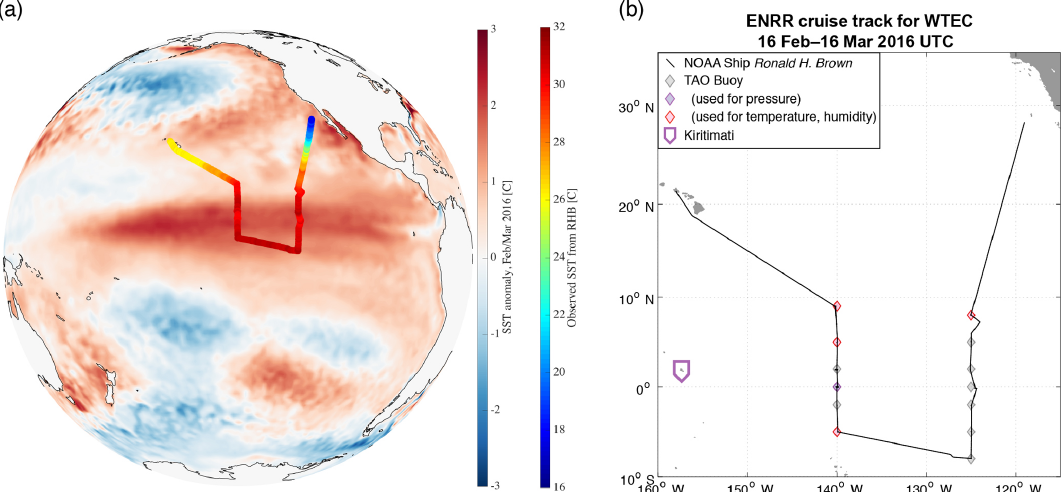
Figure 4. (a) SSTs observed by NOAA Ship Ronald H. Brown during ENRR, overlaid on SST anomalies. The latter are the departure from the ERA-Interim (Dee et al., 2011) 1979–2016 February through March mean. (b) The cruise track of NOAA Ship Ronald H. Brown overlaid on a map showing the location of the TAO buoys visited during its cruise and also the location of Kiritimati Island. The buoys used in the post-processing of the ship’s surface pressure, temperature, and humidity are highlighted.